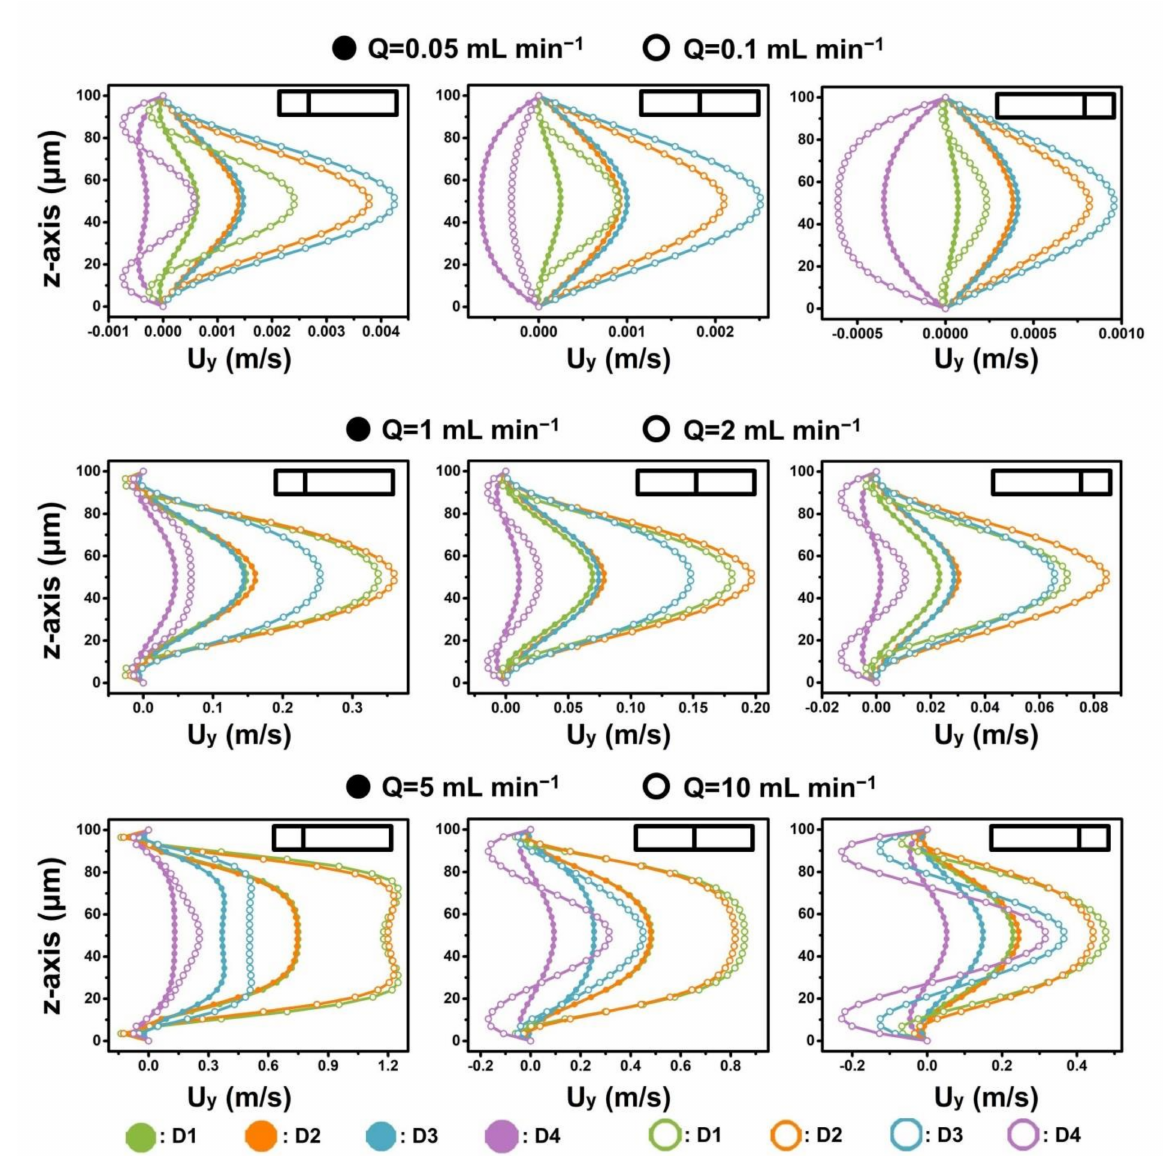
Figure 4. Quantitative analysis of fluid velocity along channel cross sections in narrow regions of different D-channels under different flow rates (0.05 to 10 mL min − 1 ). The partial results correspond to the dotted lines in Figure